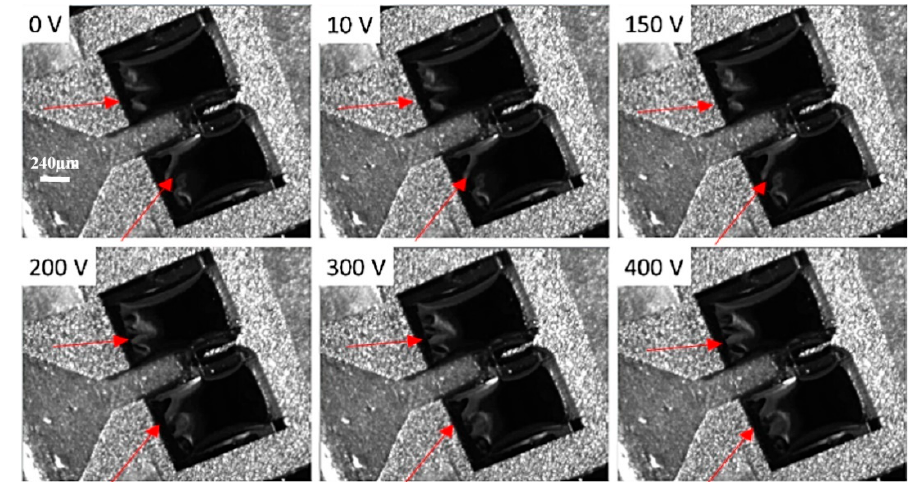
Figure 21. Waveguide mechanical frequency response. Both vertical and horizontal displacement were measured. Driving input voltages are 100 V DC applied at the bottom electrodes and +150 V AC at the top electrodes.